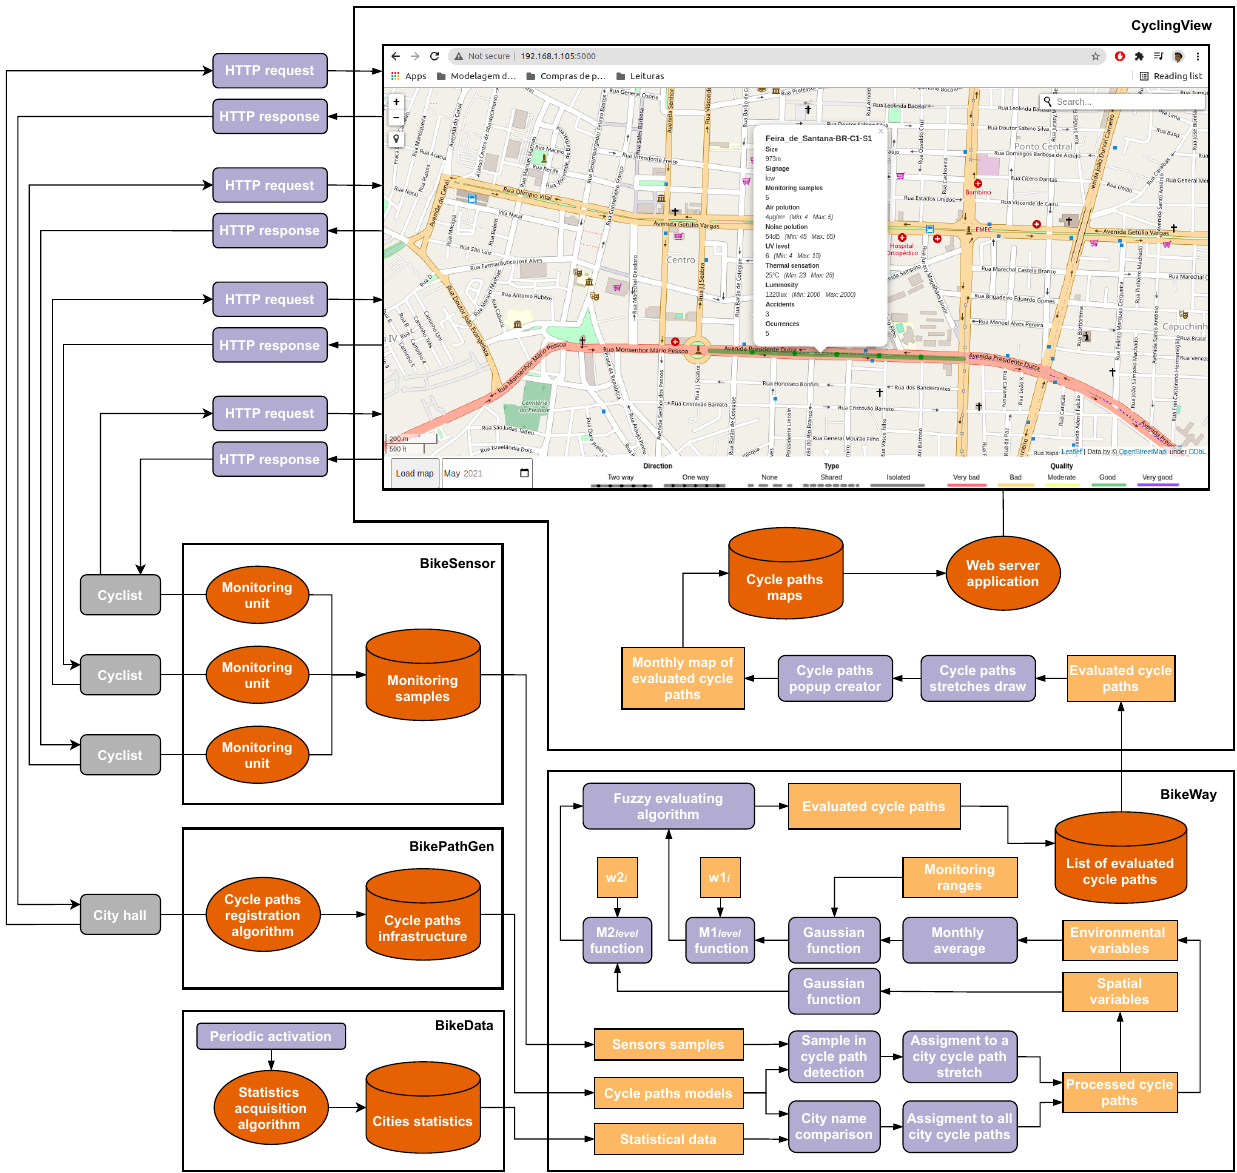
Figure 7. General diagram of the BrazilCycling implementation, exploiting the subsystems BikeSensor, BikeData, BikePath- Gen, BikeWay and